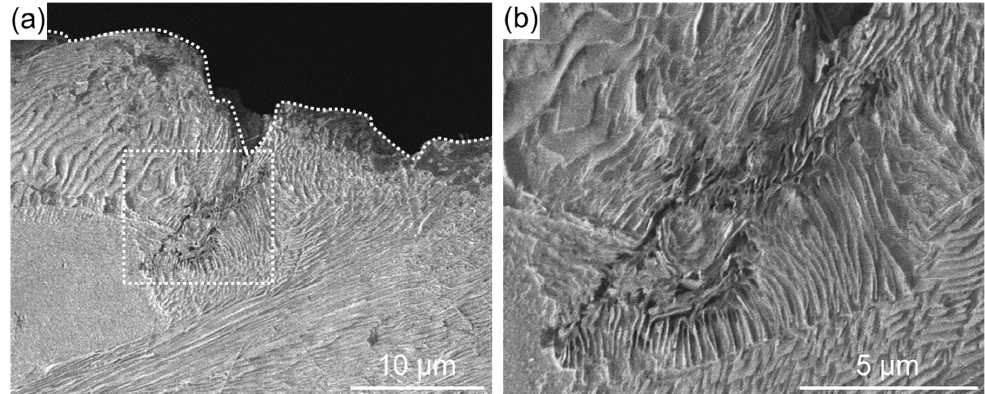
Figure 6. ( a ) Cross-sectional SEM image of a specimen after multifunction cavitation (MFC) treatment for 2 min; ( b ) Enlarged SEM image of the region indicated by the dashed box in ( b ). The dashed line indicates the specimen surface.